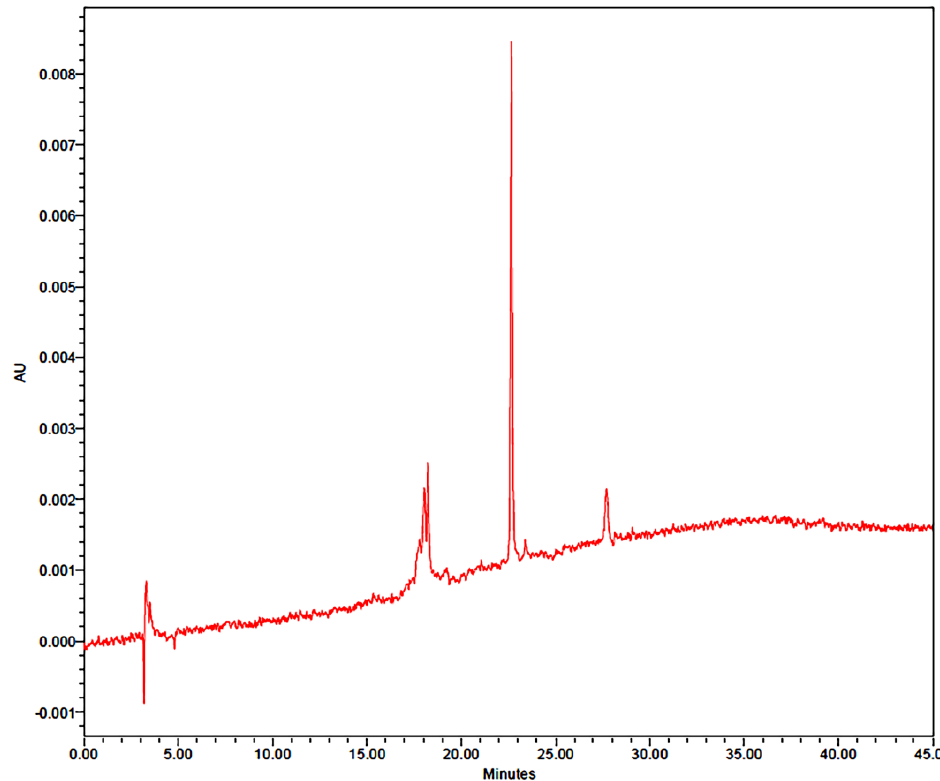
Figure 2. HPLC chromatogram of phenolic compounds of Lupinus albus L. seed extract at 335 nm.